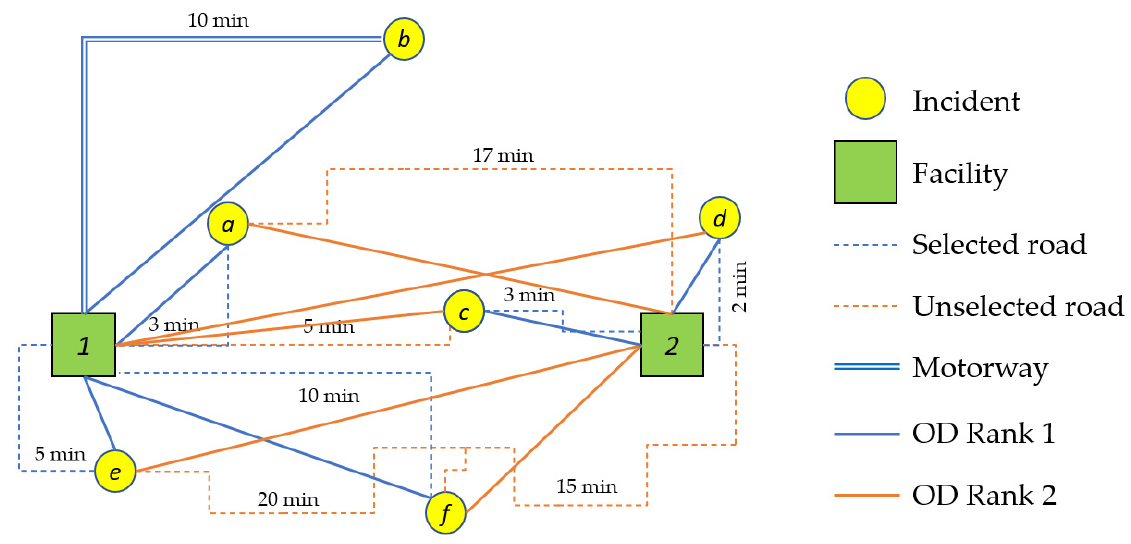
Figure 5. Illustration of OD Cost Matrix.